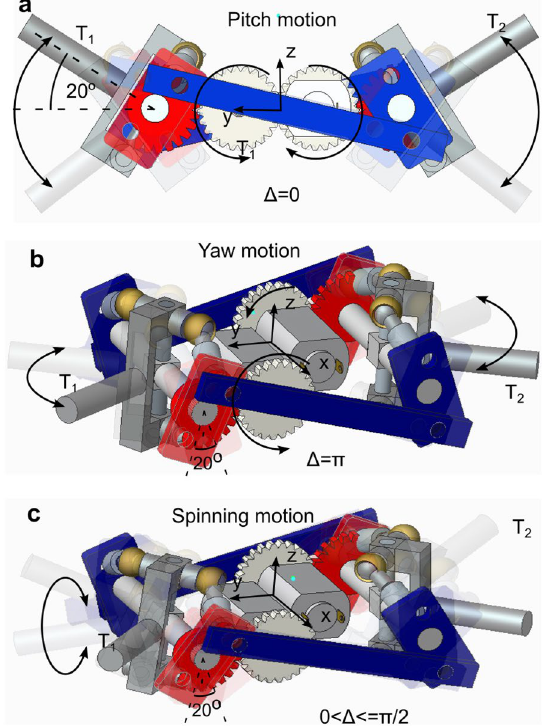
Fig. 6 Kinematics of the active joint mechanism of WORMESH-II, (cid:31) is phase different between two motors. a Pitch. b Yaw. c Spinning